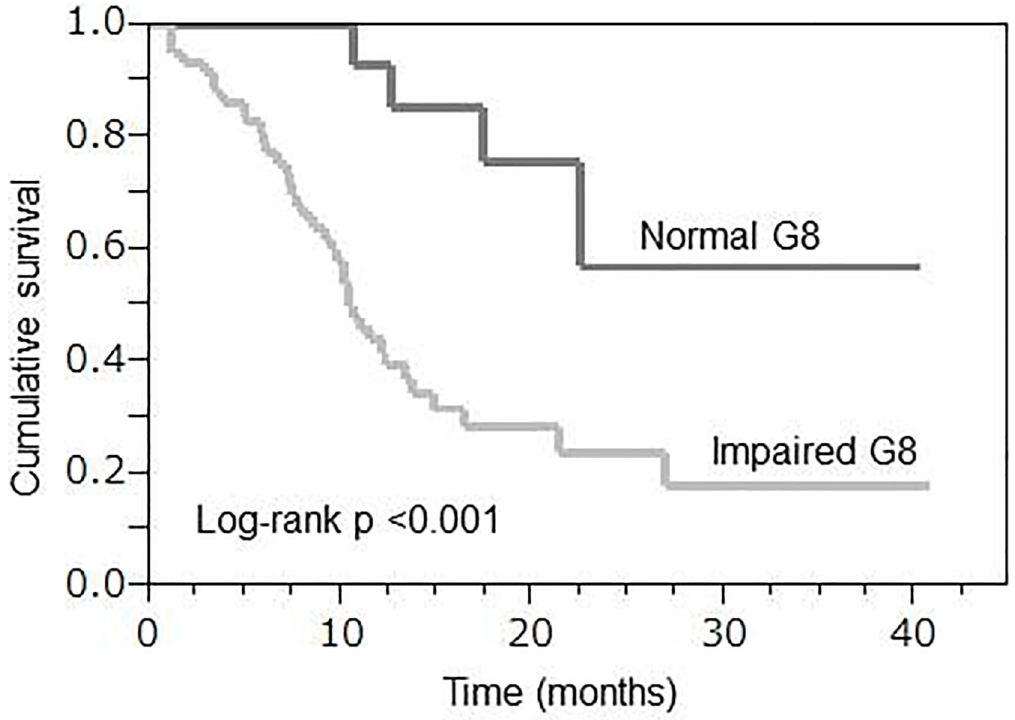
Fig 1. Overall survival according to the G8 score in patients who received chemotherapy (n = 76). Kaplan-Meier analyses for overall survival according to the G8